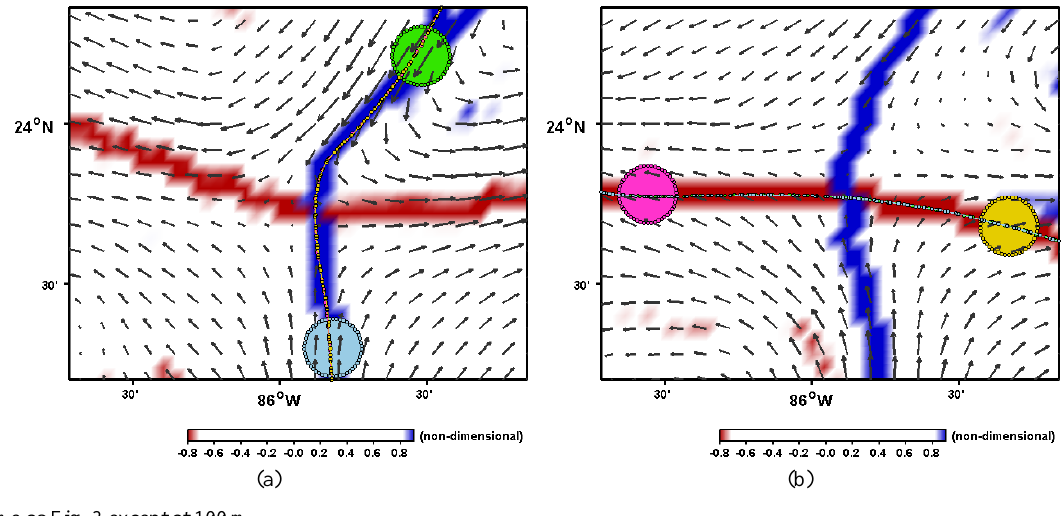
Fig. 4. Same as Fig. 3 except at